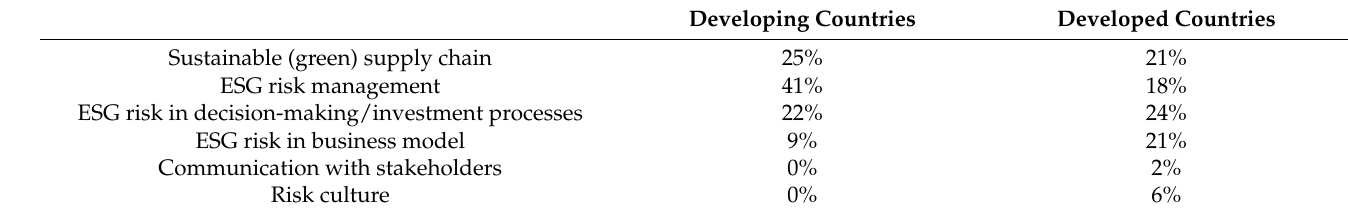
Table 7. ESG risk management practices and the level of development of the country of origin of the